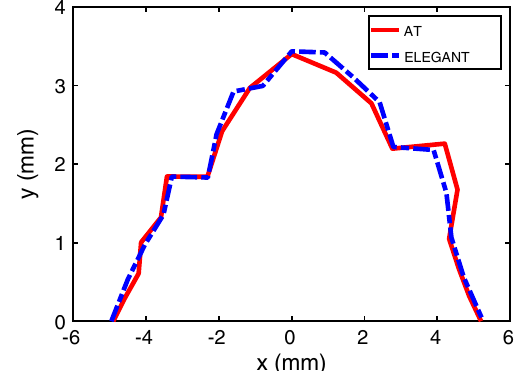
FIG. 7. Comparison of DA found by the two codes ( ELEGANT and AT ) for the ideal APS-U lattice, without physical apertures, radiation, or rf cavity.